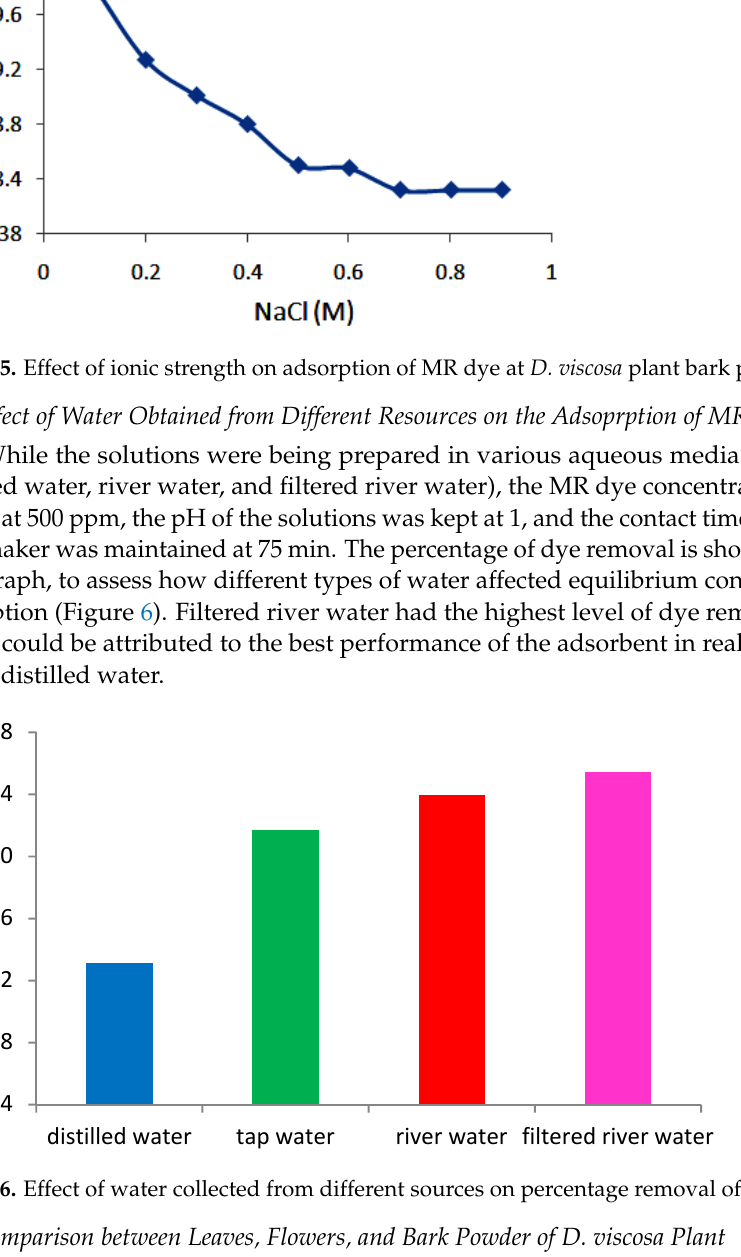
6 of 13 Figure 4. Effect of contact time on the adsorption of MR dyeon D. viscosa plant bark. 3.4. Effect of Ionic Strength on Adsorption To determine the charge on the adsorbent, the impact of ionic strength on the ad- sorption capacity was observed. To explore the impact of ionic strength, the concentra- tions of adsorbent, adsorbate, and protons (pH) were kept constant at 100 mg, 500 ppm, and pH = 1, respectively. The concentration of NaCl was changed from 0.1 to 0.9 M. With increasing salt concentration, a reduction in adsorption capacity was seen. Figure 5 de-